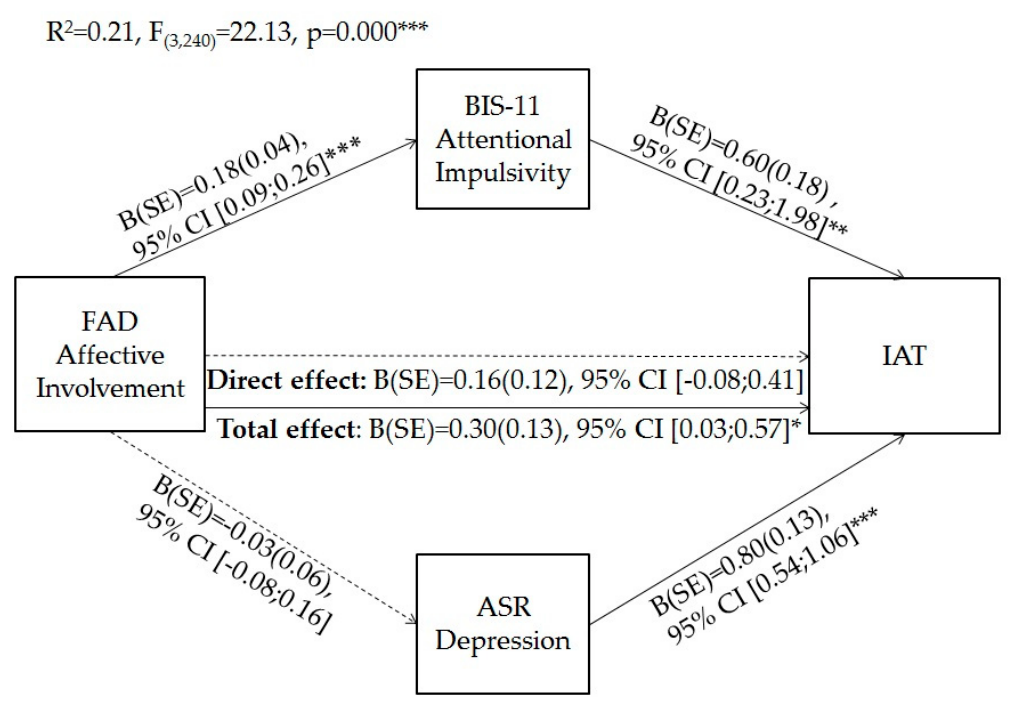
Figure 1. Parallel mediation of attentional impulsivity and depression in the relationship between affective involvement and internet addiction. * p < 0.05, ** p < 0.01, *** p < 0.001.